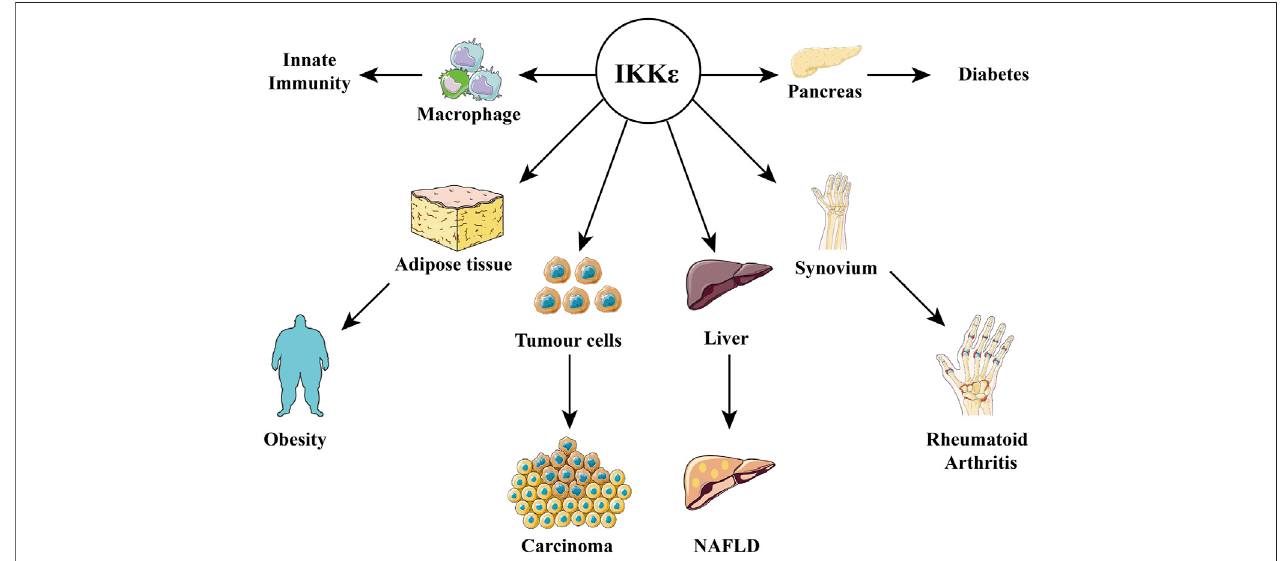
FIGURE4| RelationshipbetweenIKK ε anddiseases.IKK ε isexpressedinavarietyoftissuesandisthereforeinvolvedinthepathophysiologicalprocessesofmany diseases, including obesity, diabetes, innate immunity, rheumatoid arthritis, cancer, and nonalcoholic fatty liver disease.